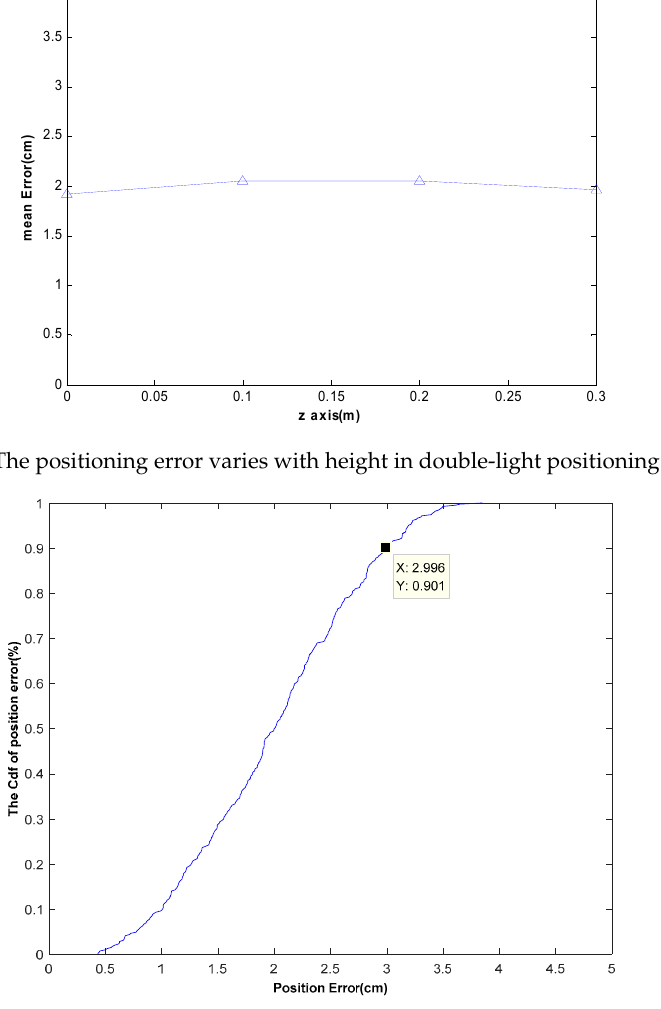
Figure 11. The CDF curves of positioning error in double-light positioning system.